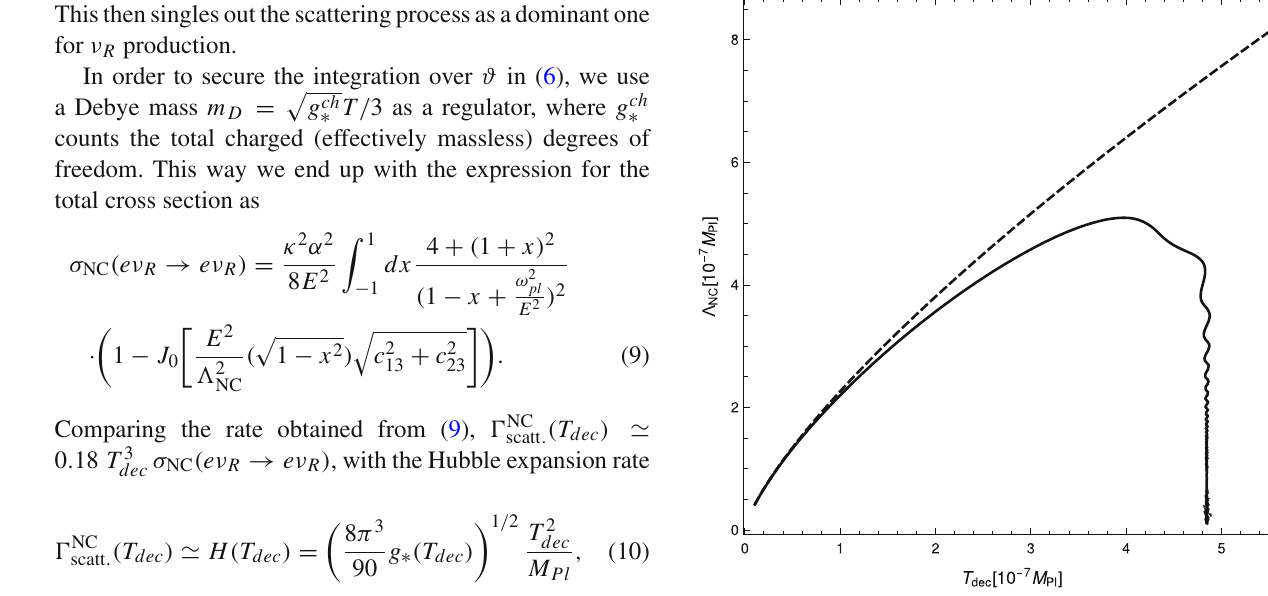
Fig. 1 Numerical plot of the scale of noncommutativity (cid:4) NC versus “decouplingtemperature” T dec evaluatedfrom(11)forthefull- θ contri- bution to the elastic e ν R → e ν R scattering amplitude (solid curve) and its first-order in θ approximation (dashed curve), for g ∗ (cid:9) g ch ∗ (cid:9) 100 and κ =